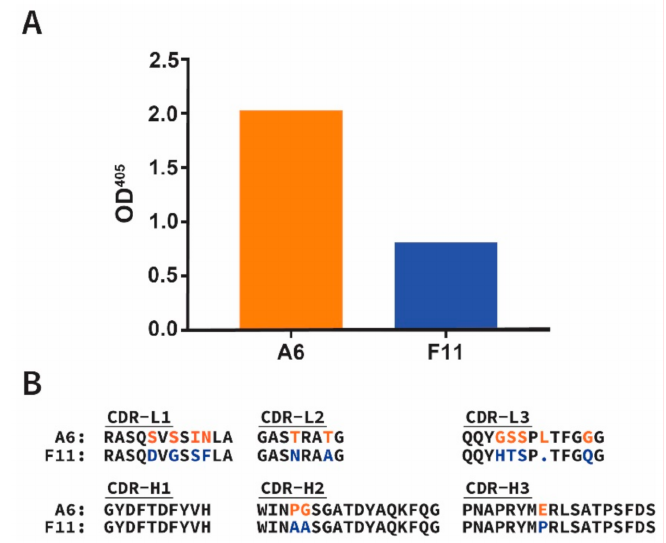
Figure 1. Identification of ABLVs G-binding Fabs A6 and F11. ( A ) Fabs specific for ABLVs G were identified by phage ELISA screening as described in the Section 2. Bound phage were detected by anti- M13 horseradish peroxidase (HRP) conjugated antibody and the resulting solution absorbance at 405 nm shown. ( B ) Amino acid sequences of light chain and heavy chain complementarity determining regions (CDR-L1-3 and CDR-H1-3, respectively) for Fabs A6 and F11. Residues which differ between A6 and F11 CDRs are indicated by red and blue font, respectively.